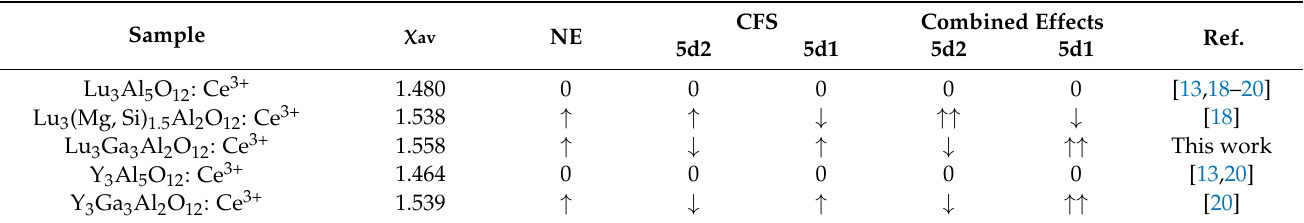
Table 1. The relationship between CFS/NE and energy levels of LuAG: Ce 3+ , Lu 3 (Mg,Si) 3 Al 2 O 12